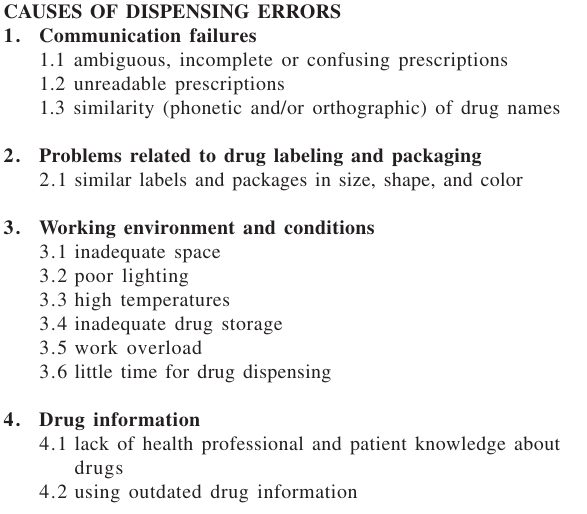
Table 2 - Causes of dispensing errors and contributing factors associated with dispensing systems* CAUSES OF DISPENSING ERRORS 1. Communication